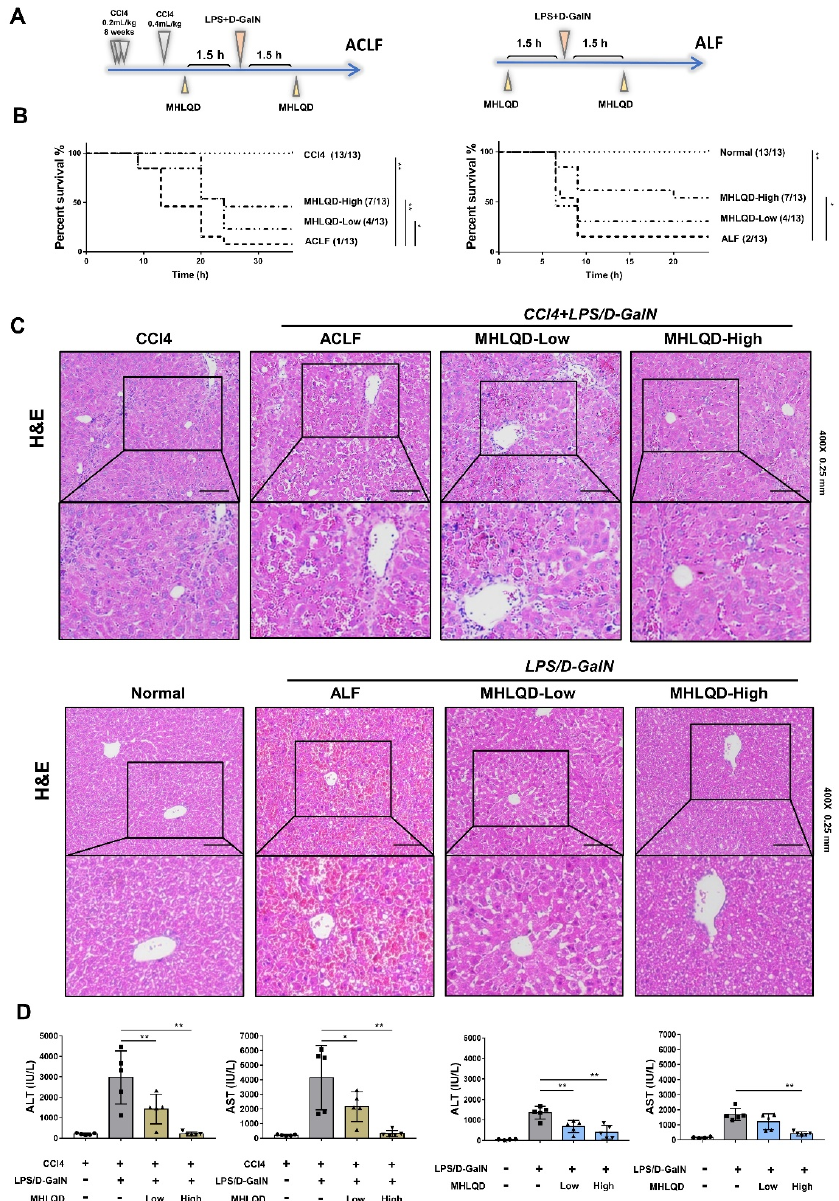
Figure 1. MHLQD improved survival rates and alleviated liver injury in ACLF and ALF mice. ( A ): The experimental design. The mice were injected with D − GalN (320 mg/kg) and LPS (50